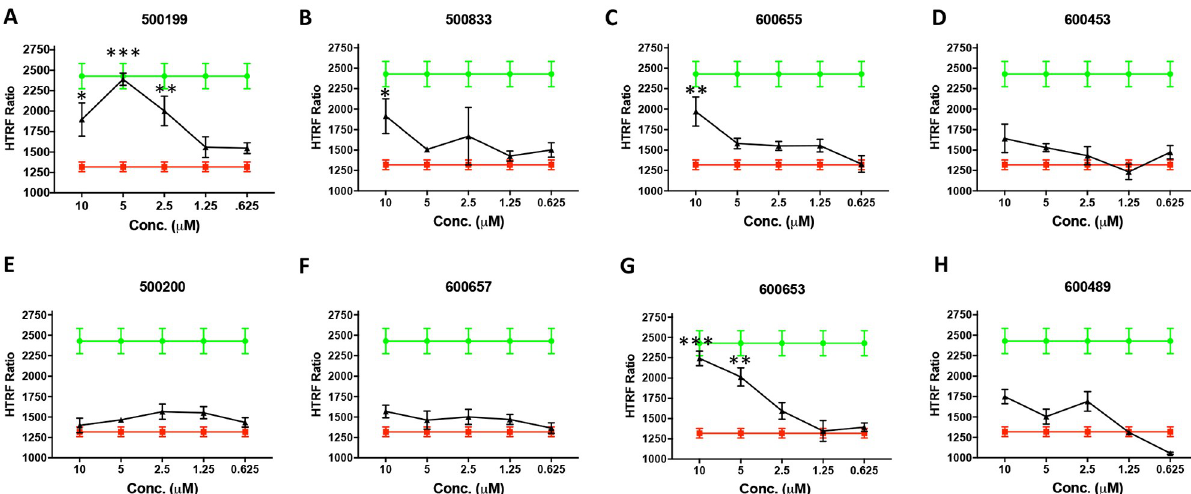
Fig 5. Validation of AMPK pathway activation by phenylbenzamide derivatives in HepG2 cells. A) Cells were seeded at 10,000 cells per well 24 hours prior to treating cells with indicated concentration of compound or DMSO (CTL) for 4 hours. 16 μ L of cell lysate was incubated with HTRF phospho-AMPK detection reagents and fluorescence emission read at 665nm and 620nm using a PHERAstar platereader. The mean and standard deviation of the HTRF Ratio from three replicate wells is shown. The unstimulated (DMSO) and positive controls lysates are shown in green and red